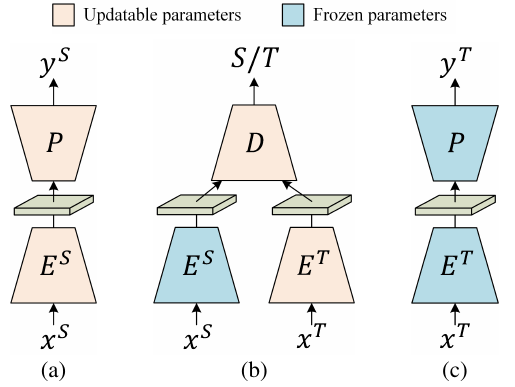
Figure 1. Steps for Adversarial Discriminative Domain Adaptation. (a) Training of the source classifier. (b) Adaptation of the target features. (c) Adapted model able to classify target samples.